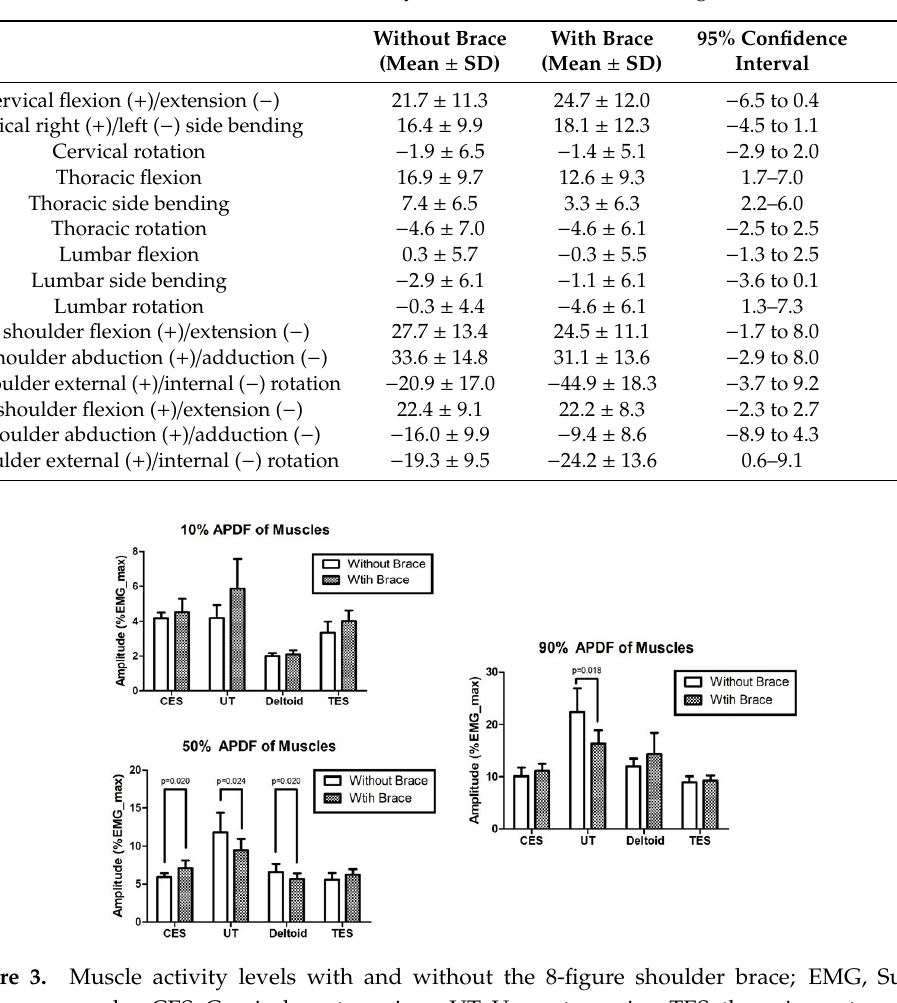
Table 1. Three-dimensional motion analysis with and without the 8-figure shoulder brace.